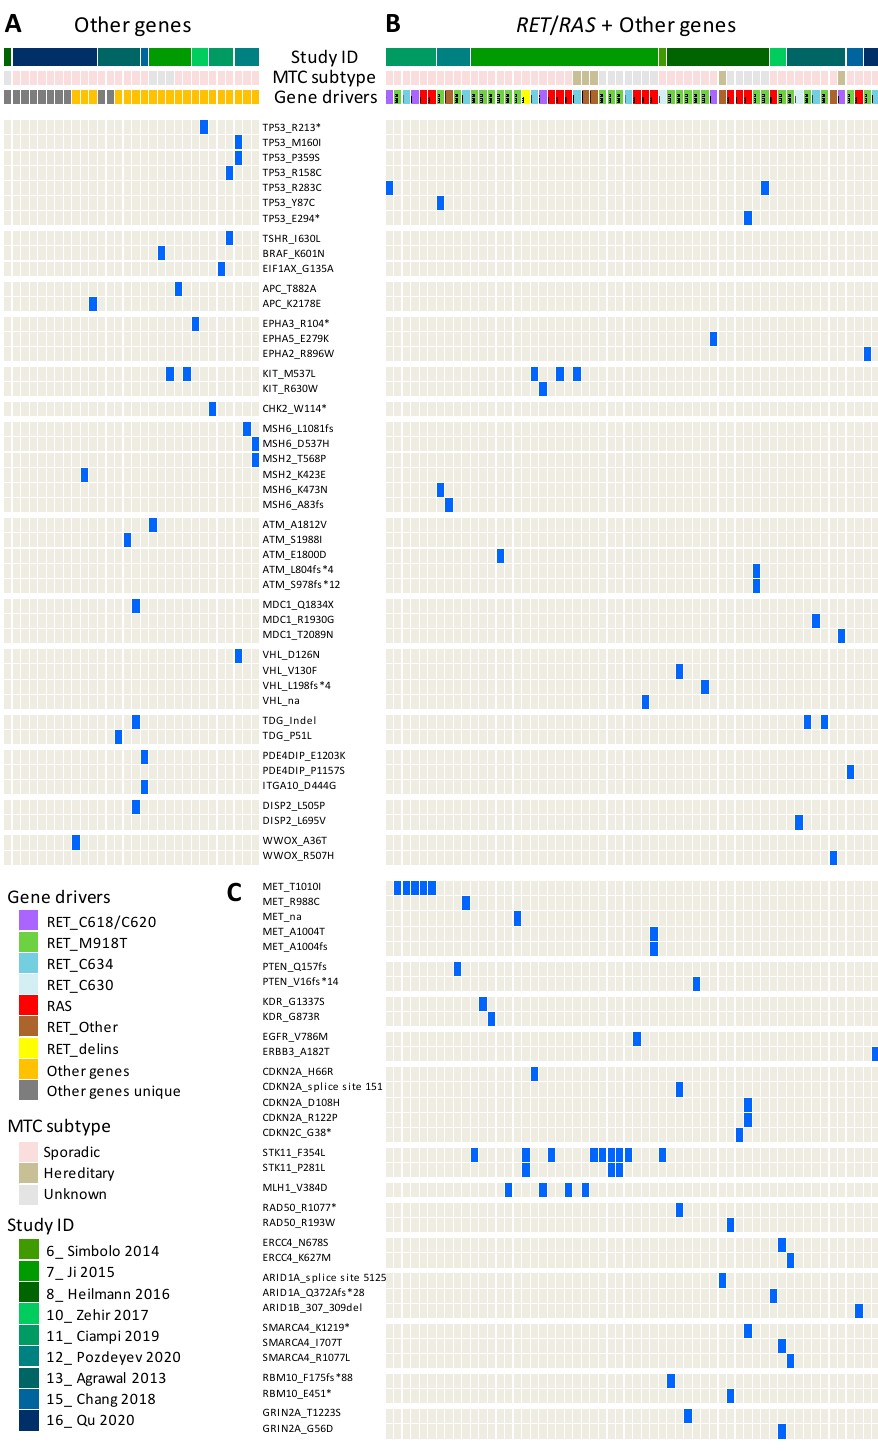
Figure 2. Mutations in “other genes” in MTC patients. The type and distribution of mutations affecting other genes different from RET and RAS is shown. Each column represents a specific patient, and the presence of the indicated mutations is indicated by a blue tag. Only genes mutated in at least two patients are shown. ( A ) Patients lacking RET/RAS mutations ( n = 30) were assigned to the group “other genes”; patients with mutations in other genes not identified in at least two patients were assigned to the group “other genes unique”. ( B ) Patients with concurrent RET/RAS mutations ( n = 58). ( C ) Genes mutated only in patients reported in ( B ). * indicates nonsense